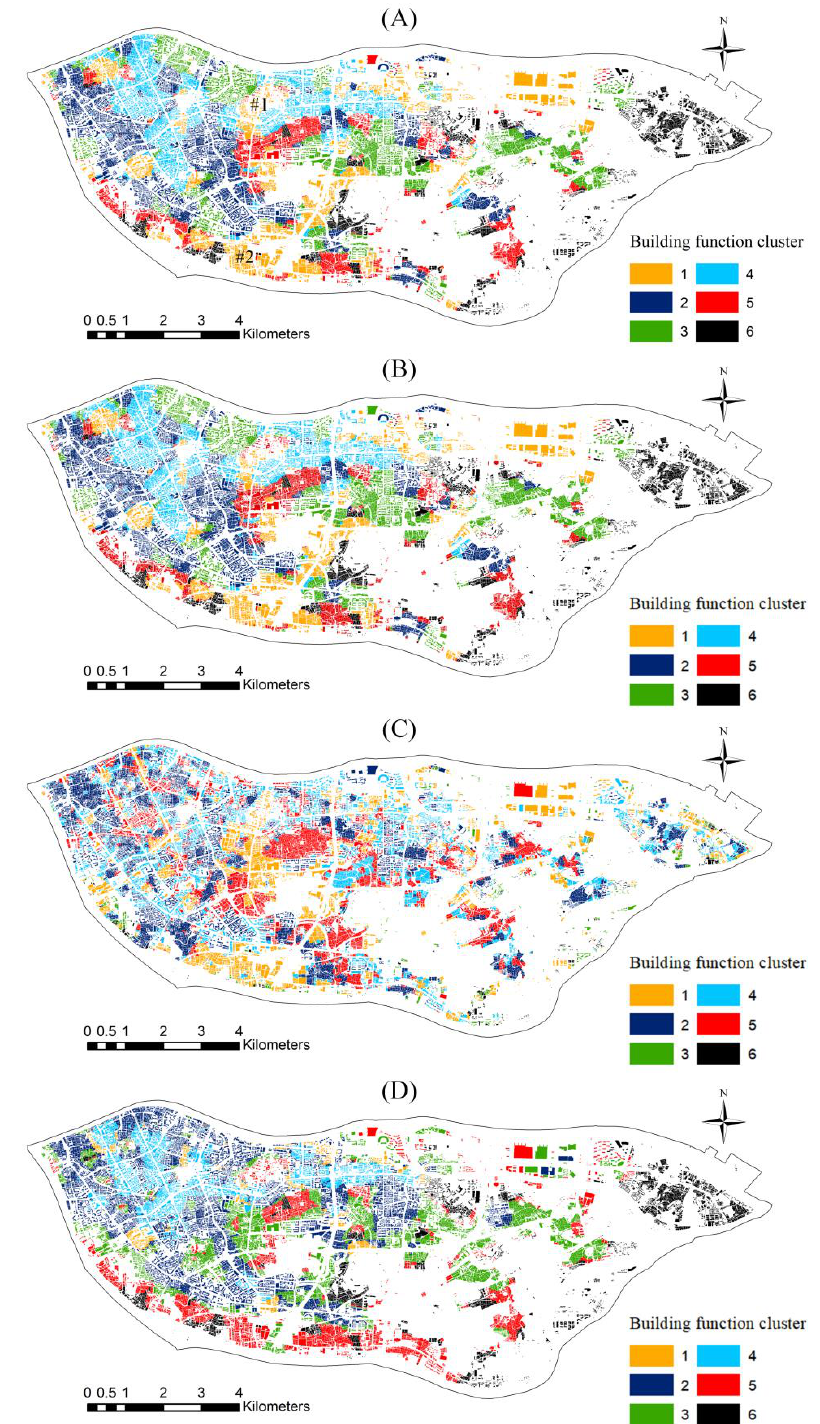
Figure 3. Spatial distribution of six building function clusters based on the di ff erent characteristics in the proposed scheme. ( A ) Clustering results derived by combining the spatiotemporal interactions among the buildings and the building vitality characteristics. ( B ) Clustering results based on spatiotemporal interaction characteristics only. ( C ) Clustering results based on building vitality characteristics only and ( D ) Clustering results obtained from the traditional